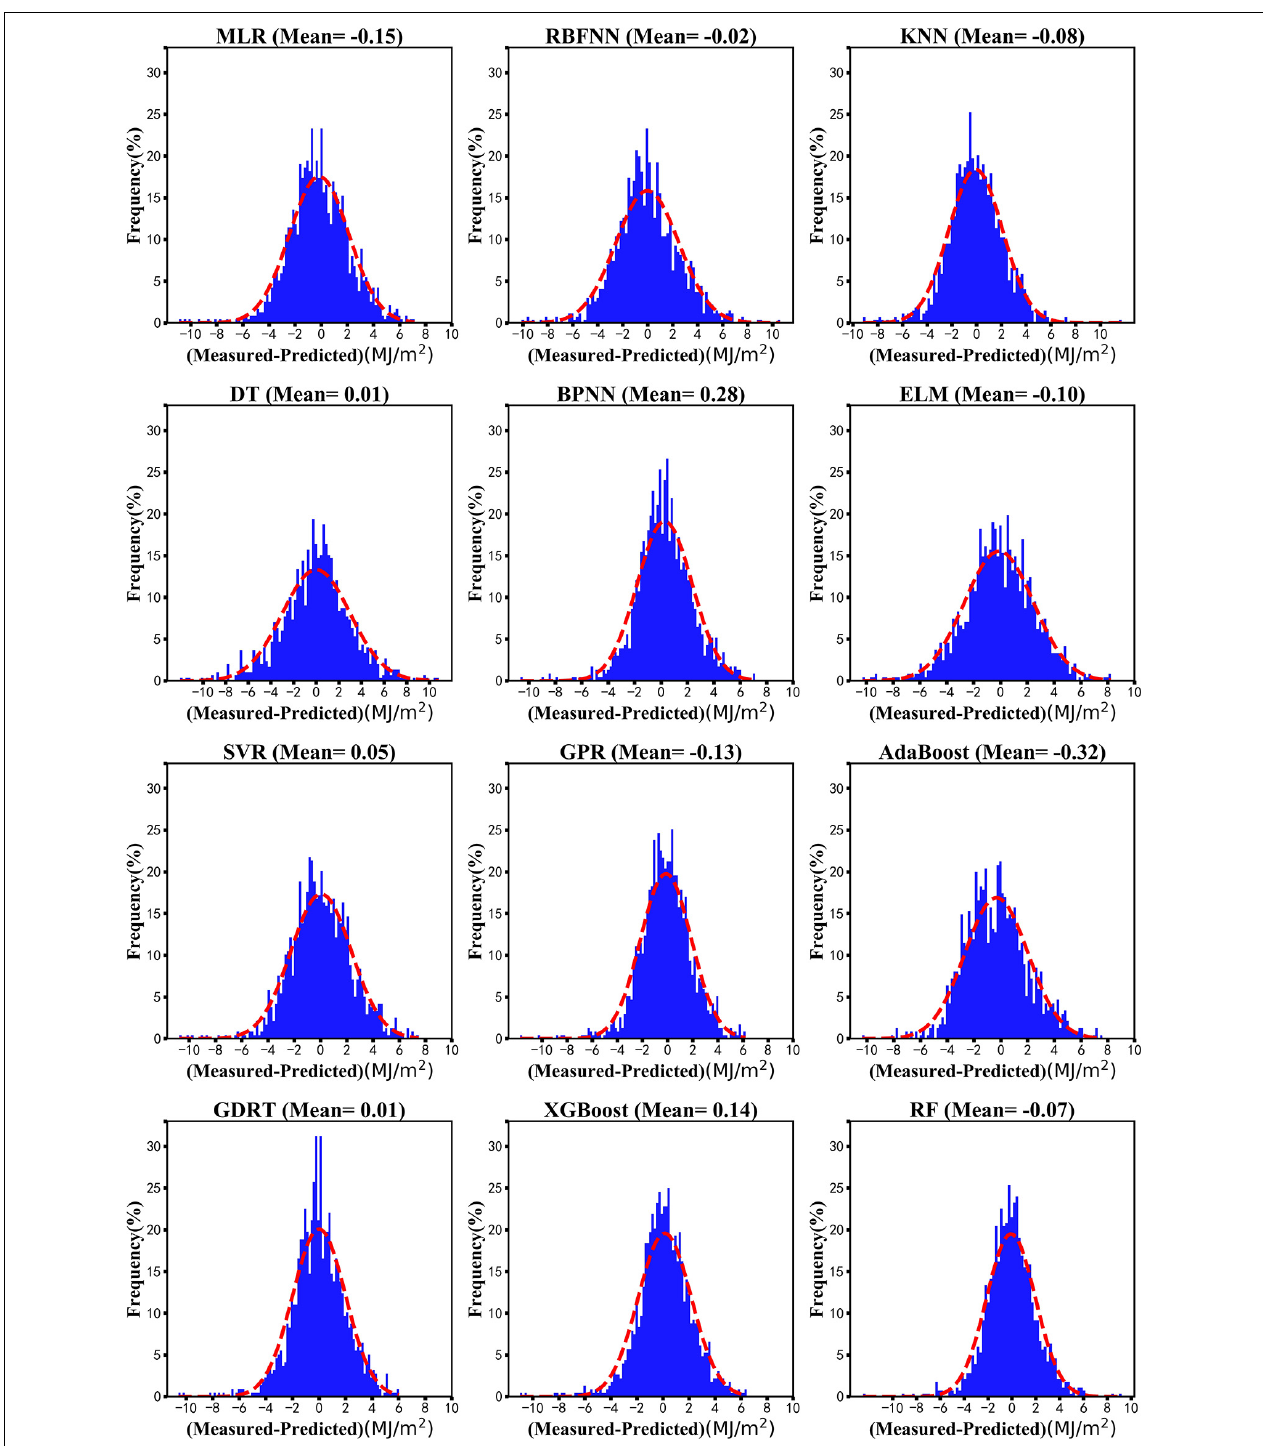
FIGURE 7 | Deviation distribution of machine learning models in predicting daily solar radiation at Ganzhou from 1980 to 2016.